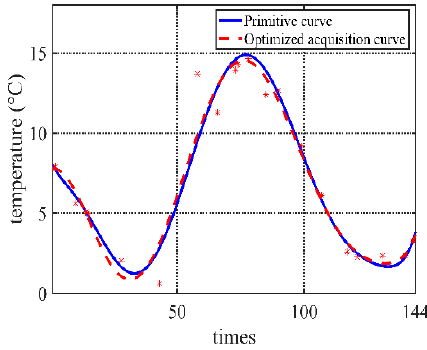
Figure 7. Comparison when FIT max = 0.5.